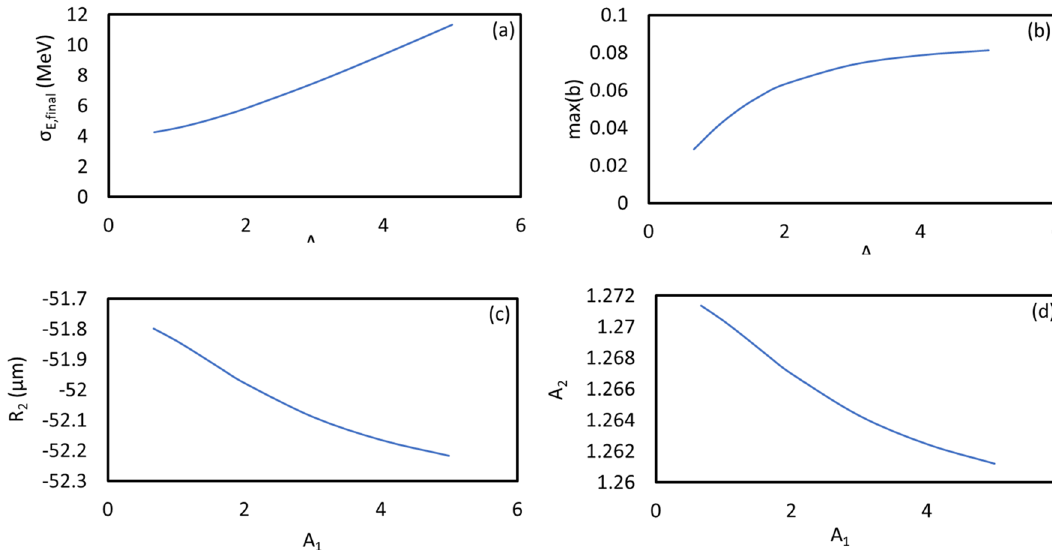
Figure 9. ( a ) The final effective RMS energy spread, ( b ) the maximal bunching, ( c ) the momentum compaction of chicane 2, and ( d ) the energy modulation of stage 2 as a function of the energy modulation of stage 1 are plotted, respectively.